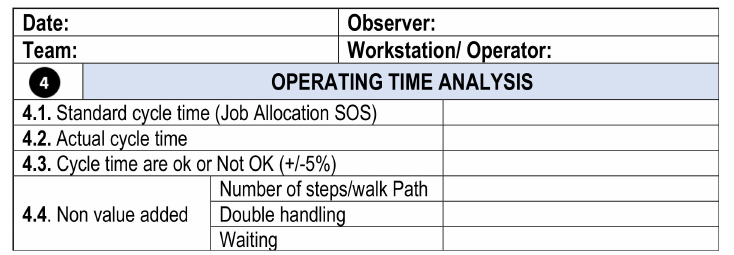
Figure 7. Questionnaire for duration analysis.